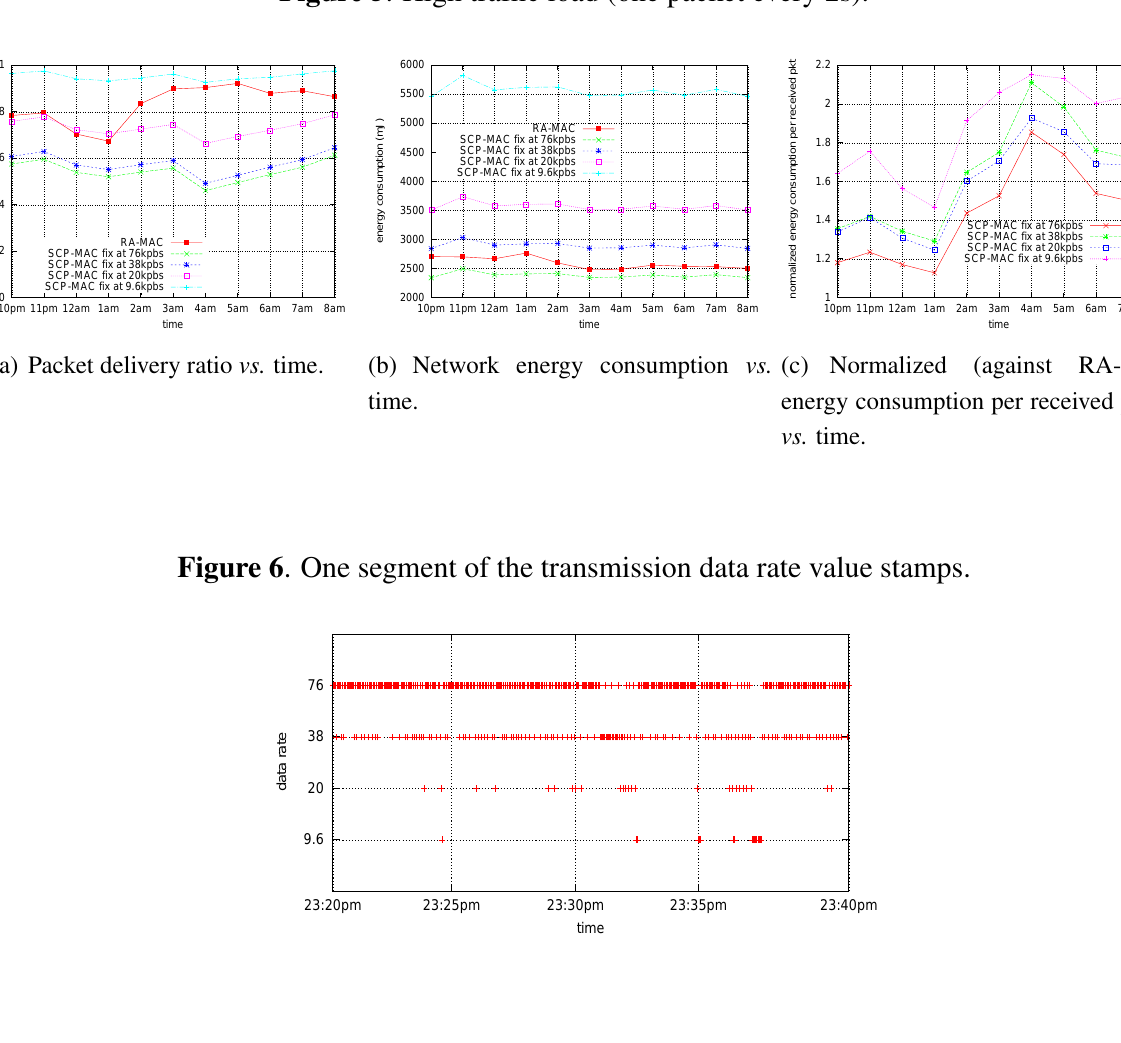
Figure 5 . High traffic load (one packet every 2s).